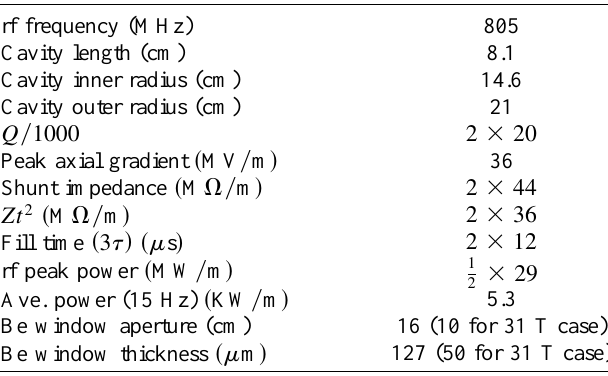
TABLE VIII. Characteristics of the rf